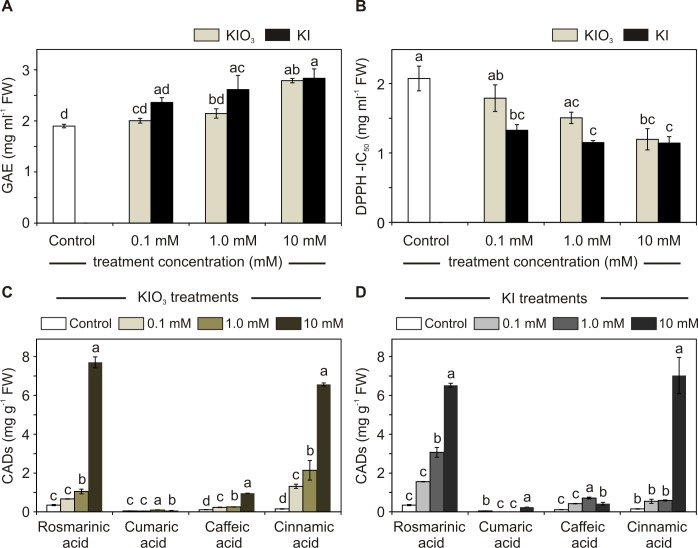
Phenolics and antioxidant power of basil plants grown in open field.Total phenolics (A) and antioxidant power (B) of control and KI or KIO3 (0, 0.1, 1.0 and 10 mM) treated plants. CADs of interest quantified in KIO3 (C) and KI (D) treated plants. Determinations were performed on basil leaves. Error bars are presented on graphs. One-way ANOVA was performed. Different letters indicate significant differences between treatments (Tukey’s test, P≤0.05).